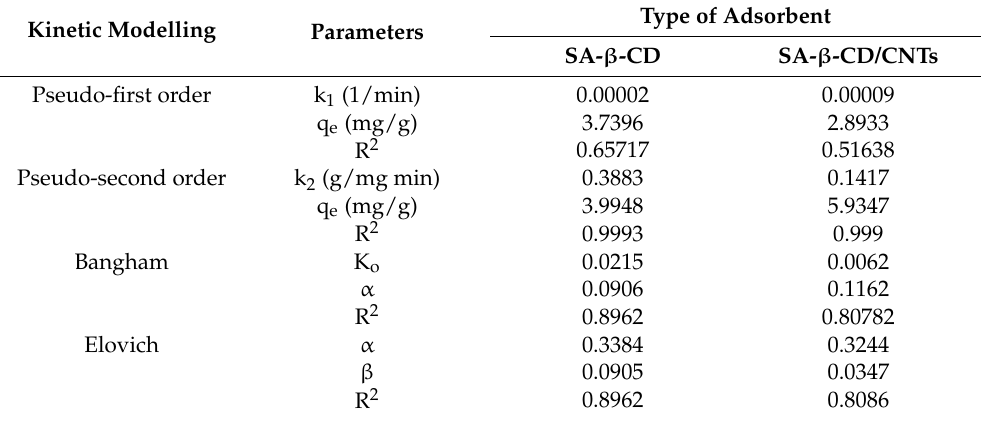
Table 1. Kinetics